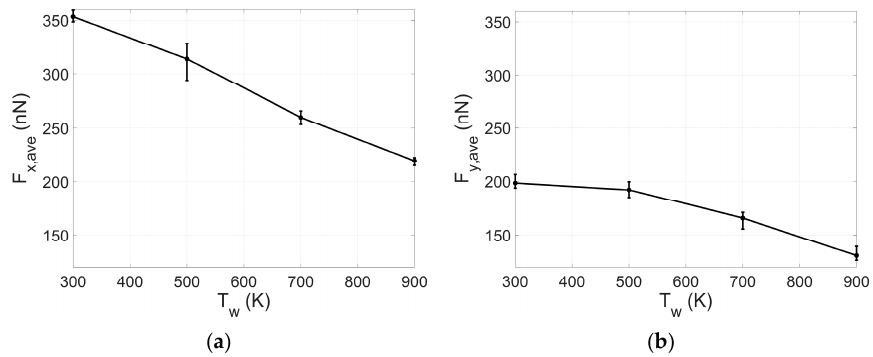
Figure 4. Cutting forces vs. workpiece temperature: ( a ) tangential forces ( F x ) and ( b ) normal forces ( F y ).